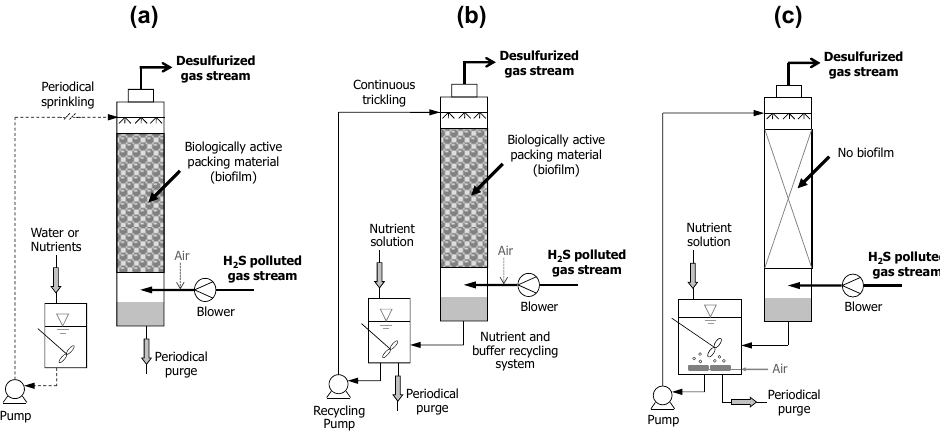
Figure 3. Biofiltration unit configurations: ( a ) Biofilter; ( b ) biotrickling filter (BTF); ( c ) Bioscrubber. In biofilter and BTF systems, the contaminated gas stream is passed through a packed bed